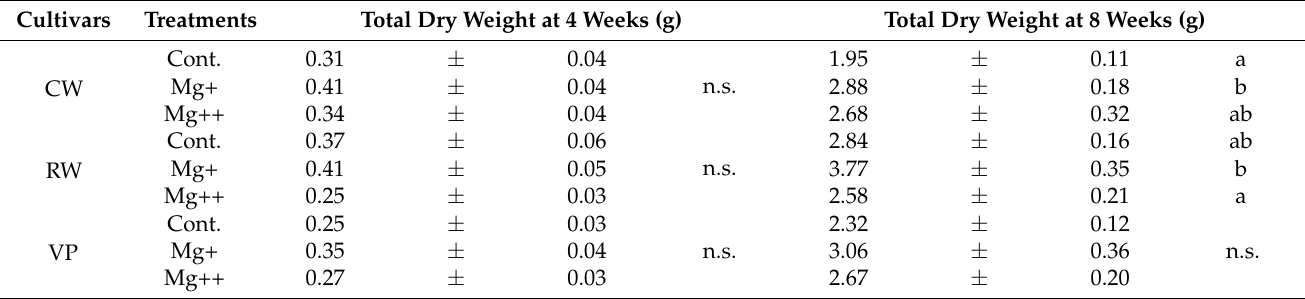
Table 3. Total dry weight in each cultivar and treatment at 4 weeks and 8